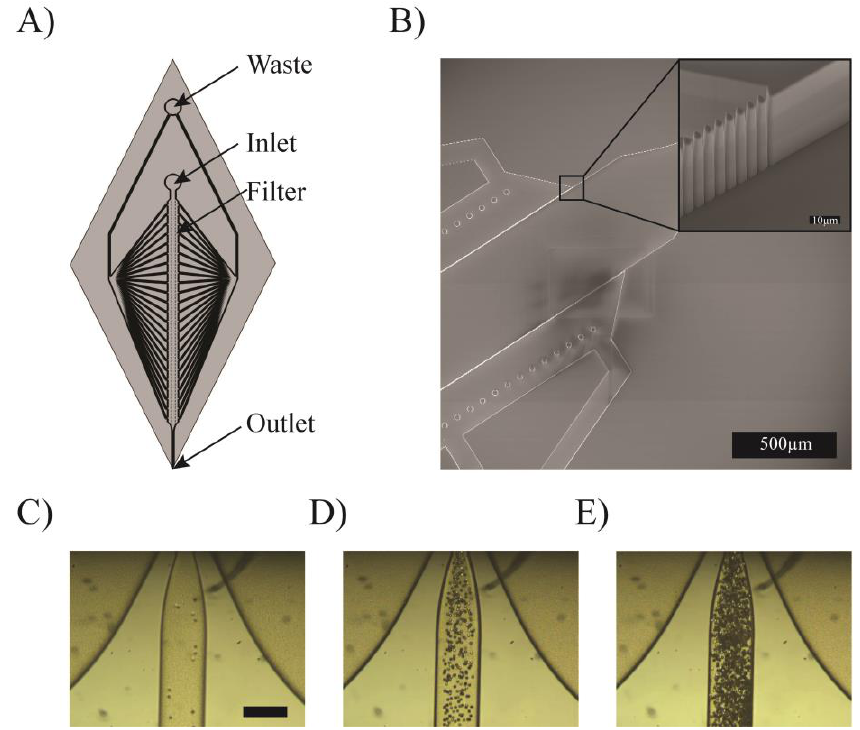
Figure 4. Crossflow filter for particle concentration. ( A ) Schematic of the print head. ( B ) Scanning electron micrograph of the crossflow filter. ( C – E ) Concentration of 8µm beads by adjusting the withdrawing factor. Scale bar = 250 µm.